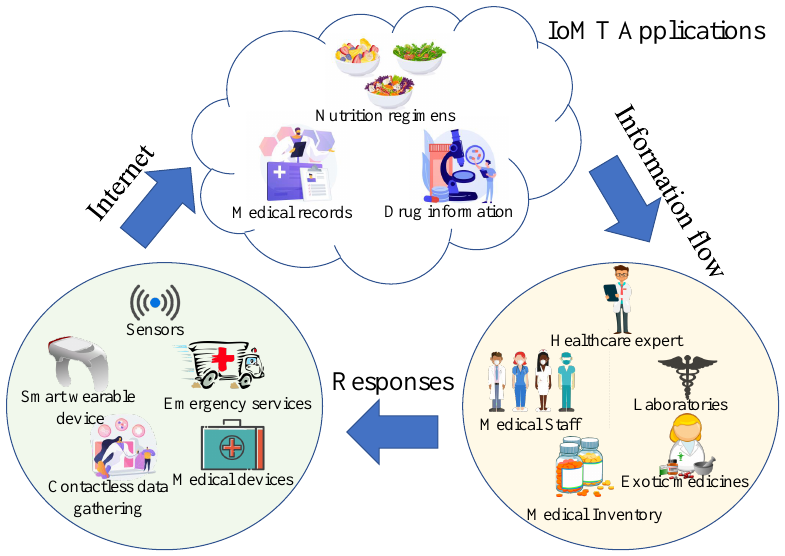
Figure 1. Internet of Medical Things and its